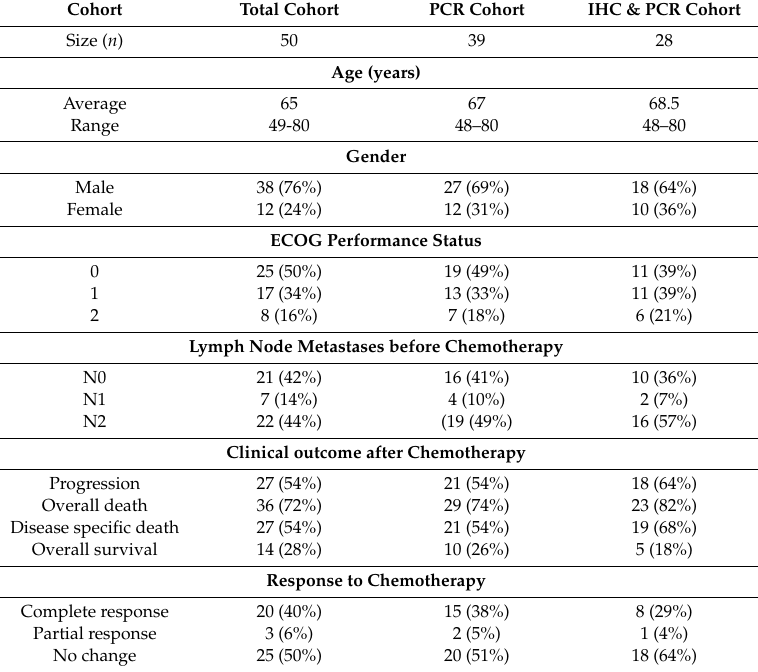
Table 1. Clinical characteristics of patients in the total cohort ( n = 50), and the PCR ( n = 39) and combined IHC and PCR subcohorts ( n = 28). IHC: